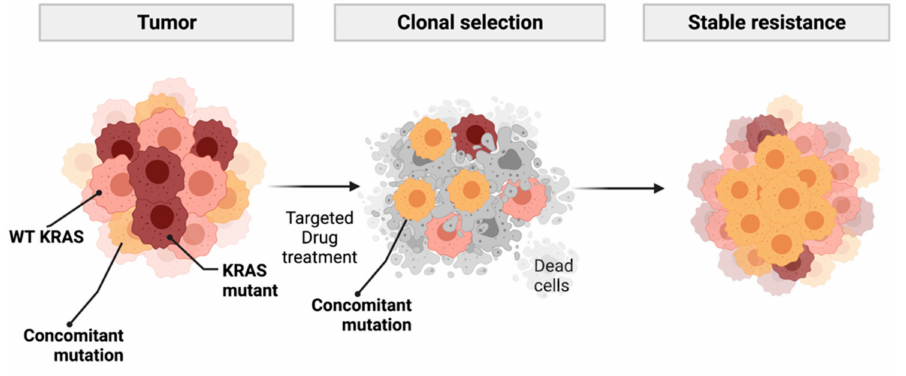
Figure 3. Schematic representation of possible subclonal evolution and drug resistance in tumors harboring KRAS concomitant driver mutations. Created with